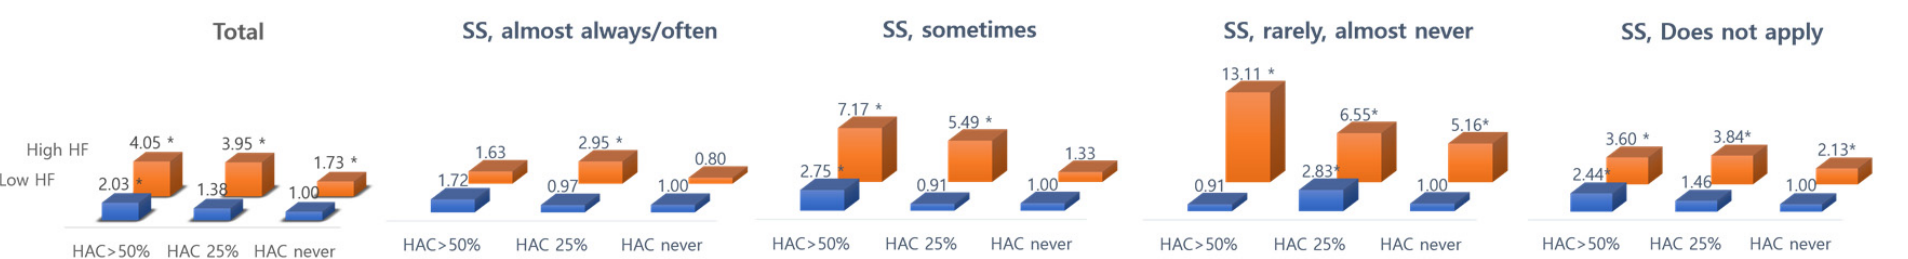
Figure 3. The interactive effects of handling angry clients x hiding feelings on mental health, stratified by social support from supervisors. * p -value below 0.05 for adjusted odds